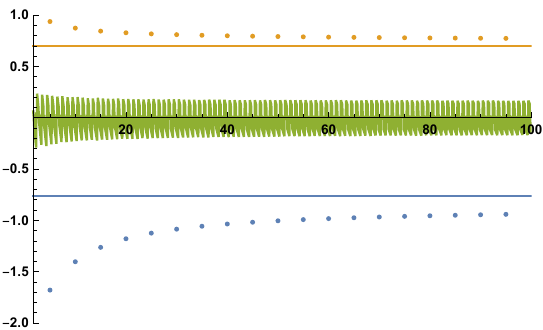
Figure 5 . We plot s ( δ, ∆) (green) as defined in (1.4) in the 2d Ising model for δ = 1 . 7 as a function of ∆. The straight lines correspond to the upper s + ( δ ) (orange) and lower s − ( δ ) (blue) asymptotic bounds. Dots represent the rigorous finite ∆ bounds (4.8).